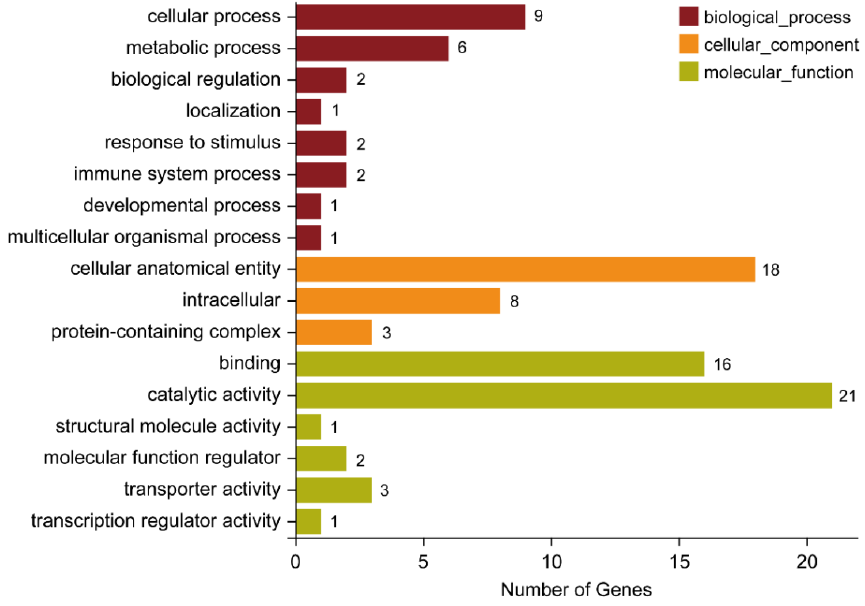
Figure 6. Gene ontology analysis of the differentially expressed genes common to the Lab_SS vs R_cfm group and the Lab_SS vs R_bft